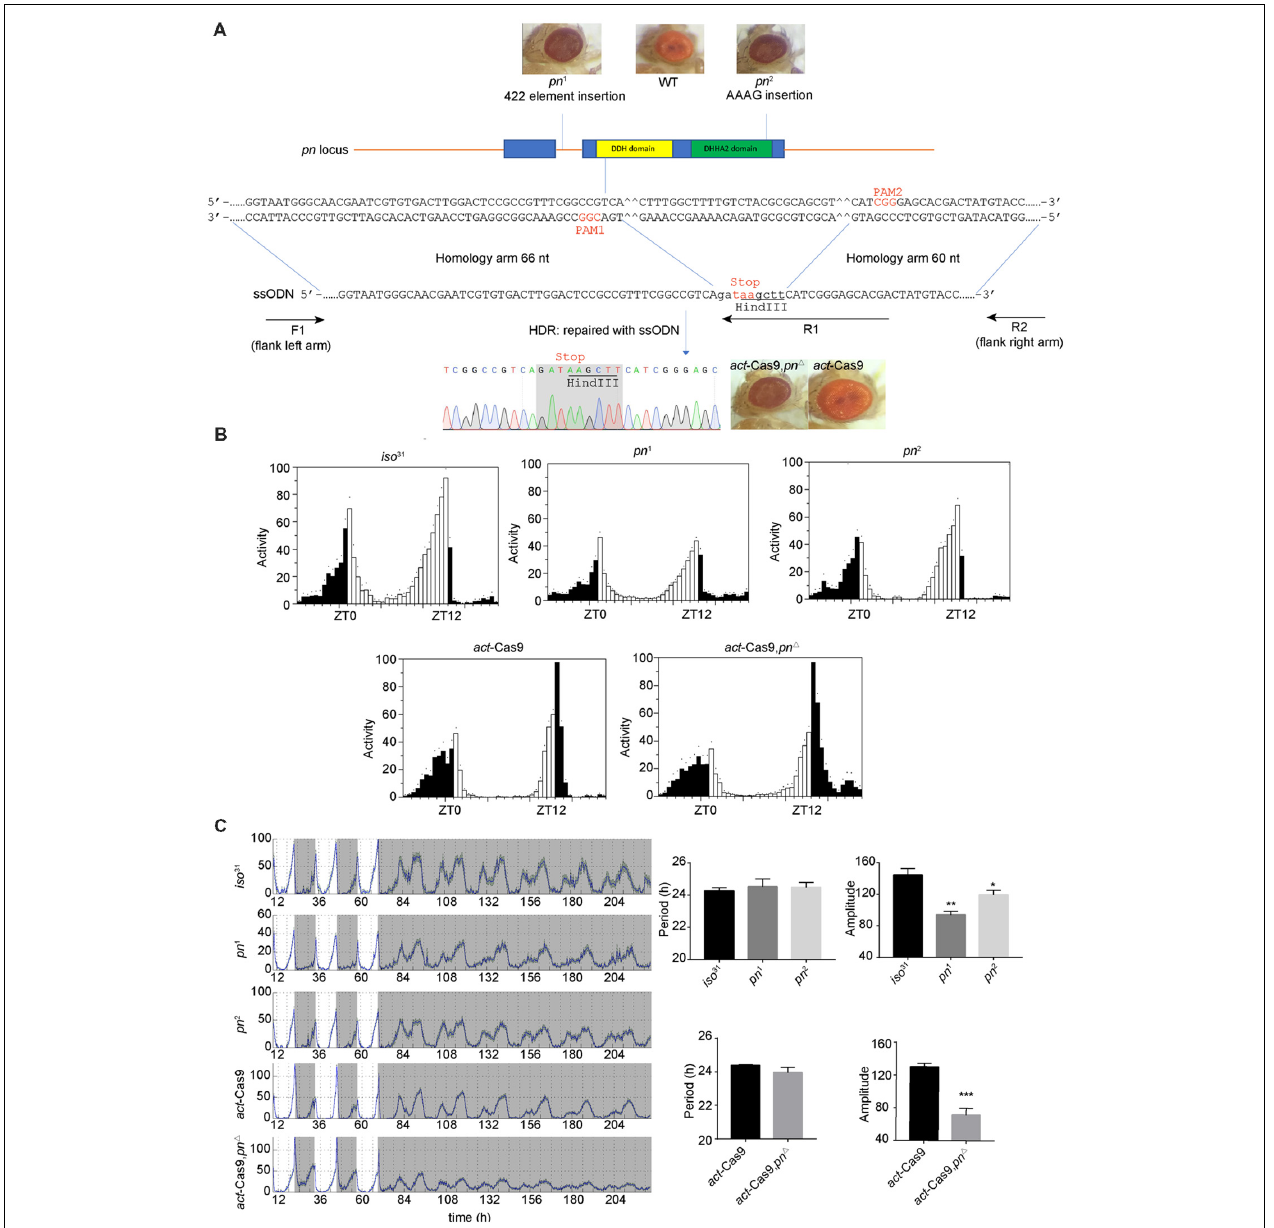
FIGURE 1 | Loss of prune ( pn ) decreases the robustness of circadian rhythm. (A) Strategy for generating pn (cid:52) mutant. The two target sites located in the DDH domain (a domain of predicated phosphoesterases) are shown. The pn -ssODN donor containing two homology arms was designed to introduce a stop codon and delete some bases of pn locus. pn 1 is an allele that contains a 422 elements insertion in the first intron of pn . pn 2 is an allele that contains an AAAG insertion at the end of DHHA2 domain (a domain often associated with the DHH domain and is diagnostic of DHH subfamily two members). F1, R1, and R2 are the primers used in molecular screening. (B) Averaged activity profiles of pn mutants during LD. White bars represent day, black bars represent night, Zeitgeber time (ZT) is indicated on the x axes. The dots above the bars indicate standard errors of the means (SEM). (C) Actograms, period, and amplitude of pn mutants and controls. The period and amplitude are shown as means ± SEM ( n = 32–40). ∗ P < 0.05, ∗∗ P < 0.01, ∗∗∗ P <